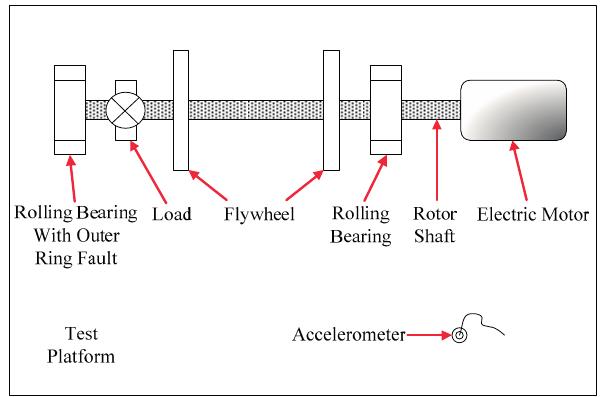
Figure 10. Rolling bearing fault experimental